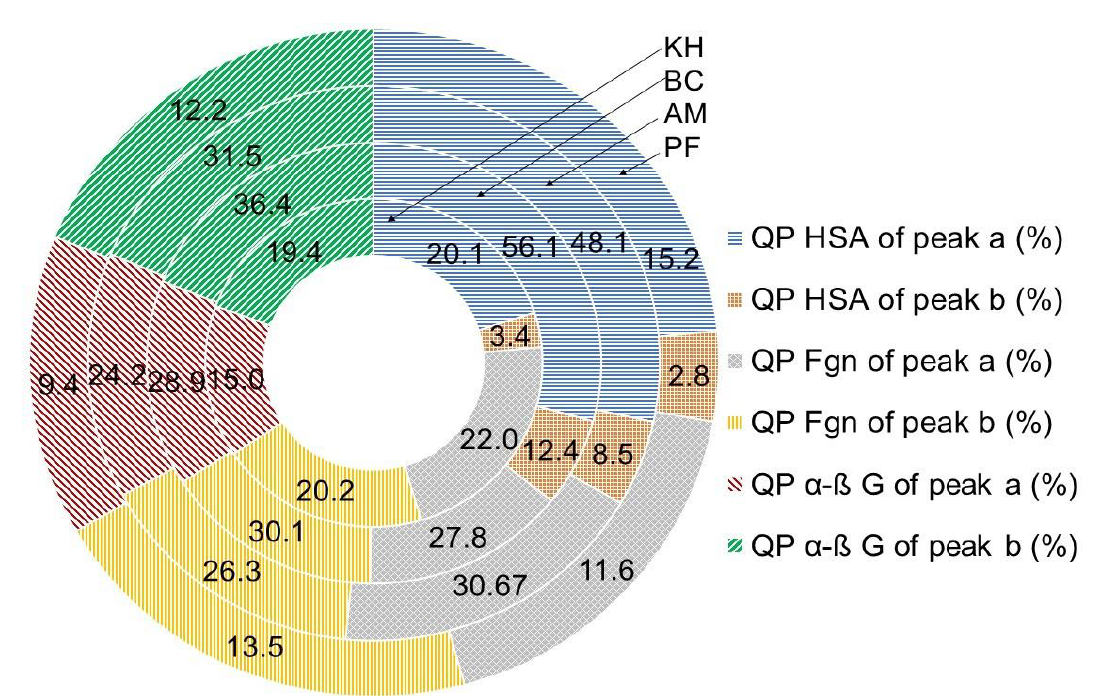
Figure 10. The quenching properties (QP, %) of fruit-extracted polyphenols based on interaction with human serum proteins and fluorometric measurements. Abbreviations: KH, Actinidia (A.) deliciosa cv. Hayward; BC, A. eriantha cv. Bidan; AM, A. arguta cv. Cheongsan; PF, Diospyros kaki Thunb. cv. Fuyu; HSA, human serum albumin; α-β G, α-β-globulin; Fgn, fibrinogen. The locations and values of peaks a and b are shown in Figures 7–9 (for interpretation of the references to color in this figure legend, the reader is referred to the web version of this article).